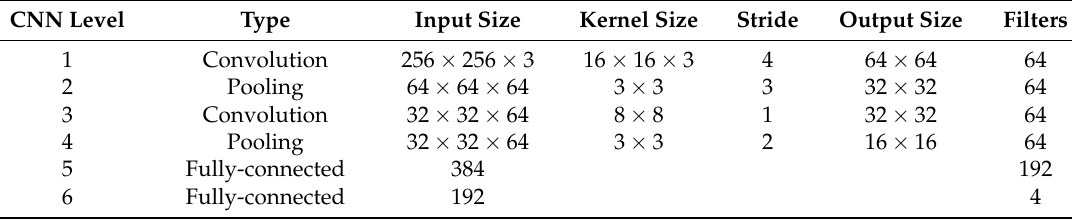
Table 1. Parameter values employed during the training of the CNN